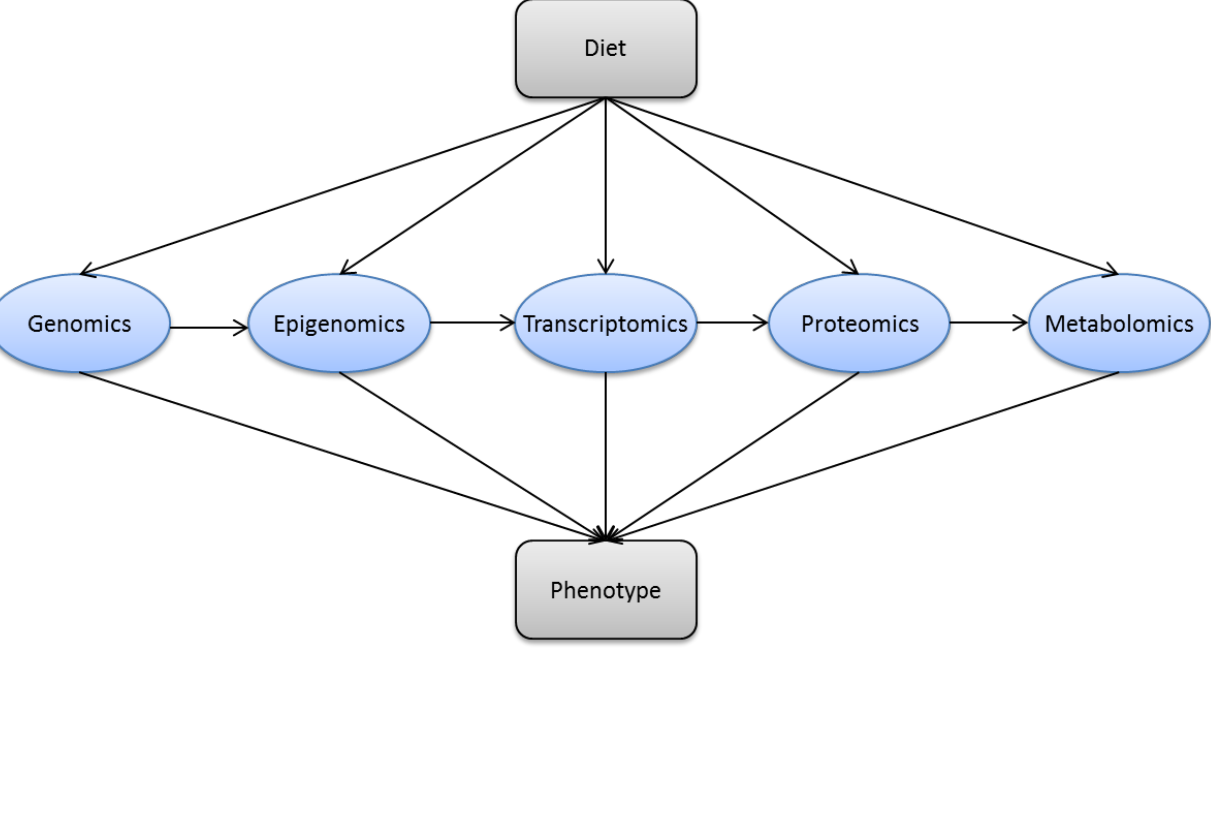
Figure 4. Dietary factors may interact with multiple biological processes. (Genomics) nutrients interact with genes and alter functional outcomes like dietary treatment of phenylketonuria; (epigenomics) nutrients may induce epigenetic changes like fatty acids promote methylation of the PGC-1α promoter; (transcriptomics) nutrients may influence gene expression as ligands for nuclear hormone receptors; (proteomics) nutrients may post-translationally modify proteins, e.g., protein-energy malnutrition leads to post-translational modifications of transthyretin; and (metabolomics) nutrients may change the metabolomic signature in the blood, e.g., carotenoids are biomarkers of fruit and vegetable